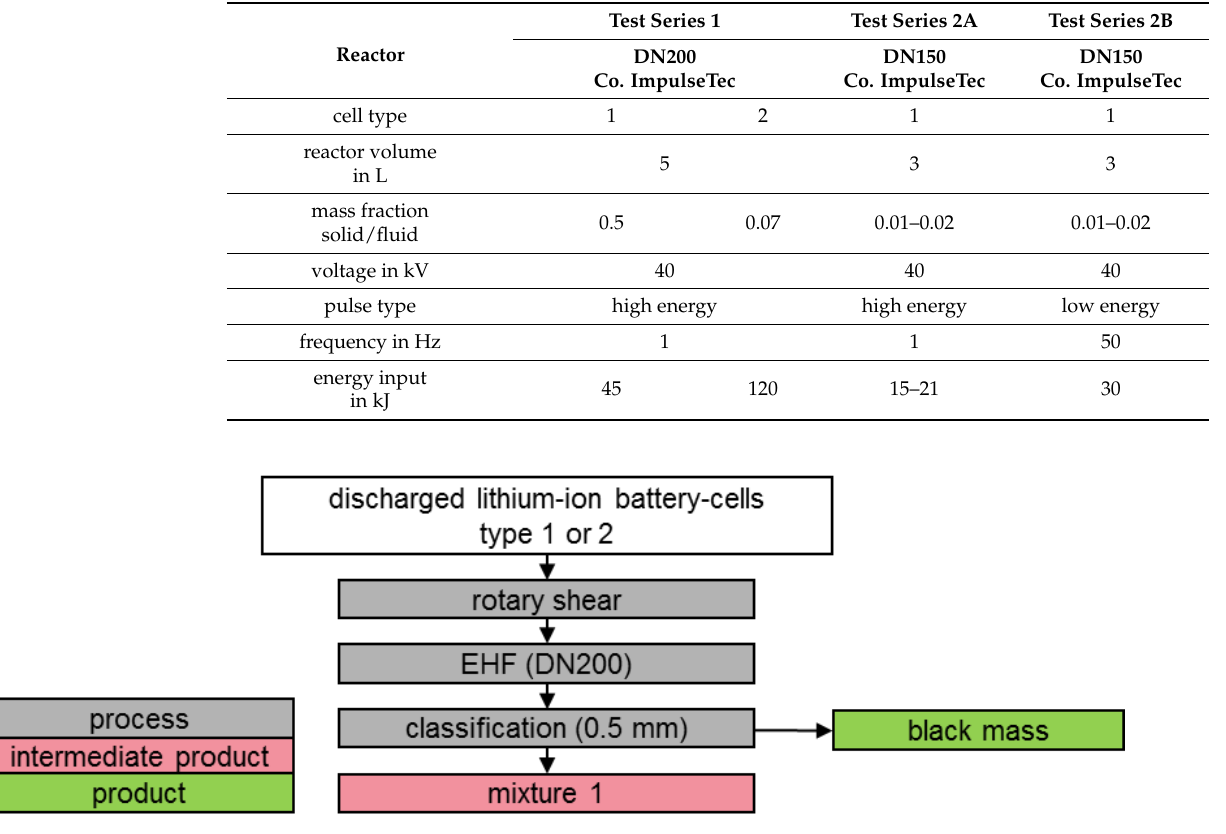
Table 2. Overview of the EHF test parameters.